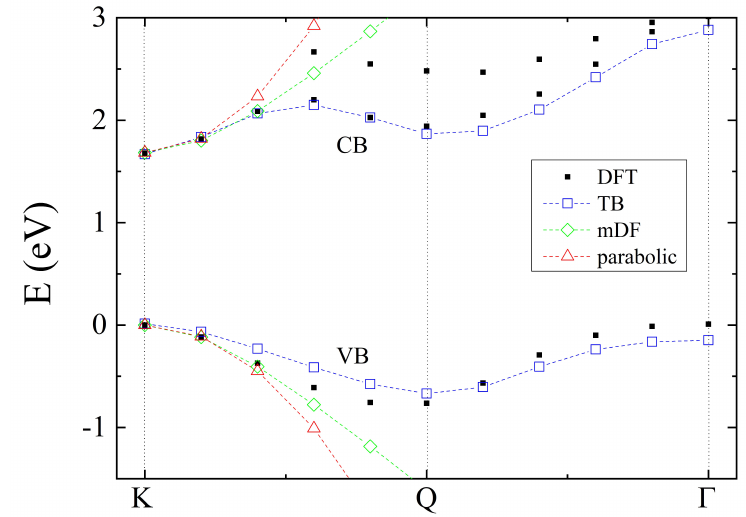
Figure 6. Comparison between dispersion models along the K − Γ line. DFT dispersion is denoted by black circles, TB by blue rectangles, massive Dirac fermion by green diamonds, and parabolic (effective mass) model by red triangles. The corresponding connecting lines are shown as a guide to the